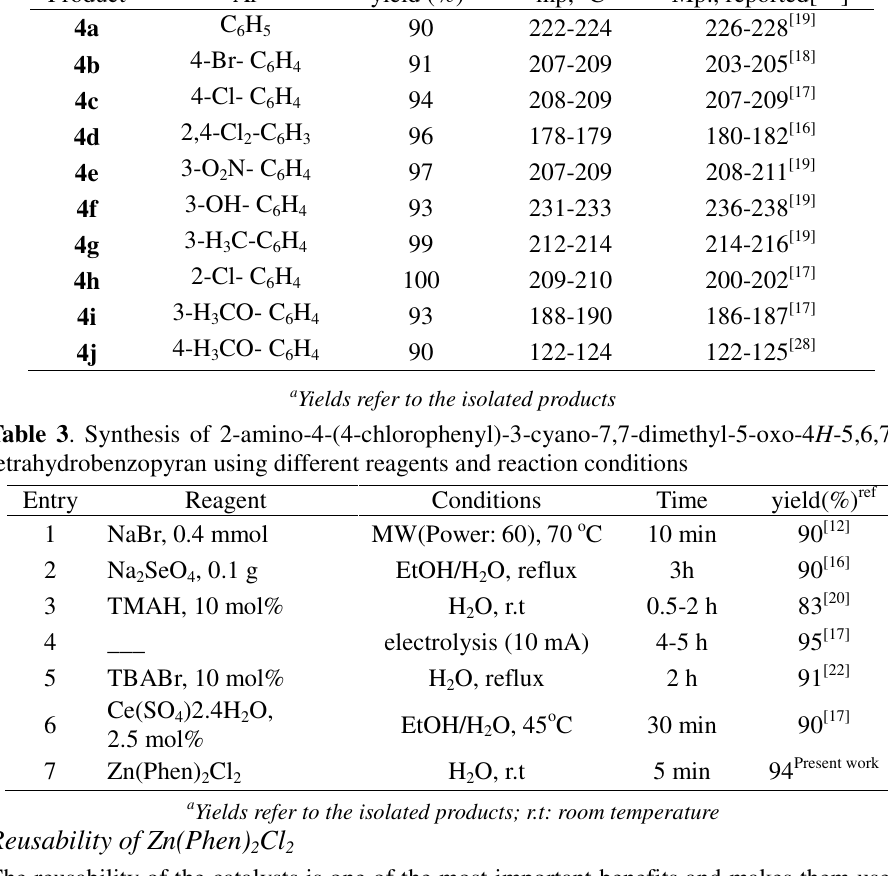
Table 2. Synthesis of 4 catalyzed by Zn(Phen)